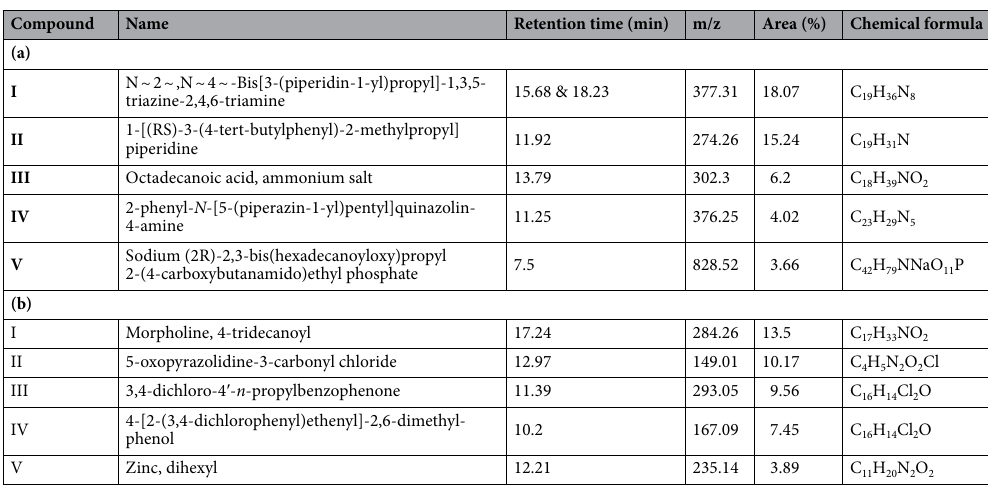
Table 5. Major compounds identified by UPLC-MS in bioactive fraction of ethyl acetate extract of (a) Bacillus subtilis and (b) Trichoderma harzianum.